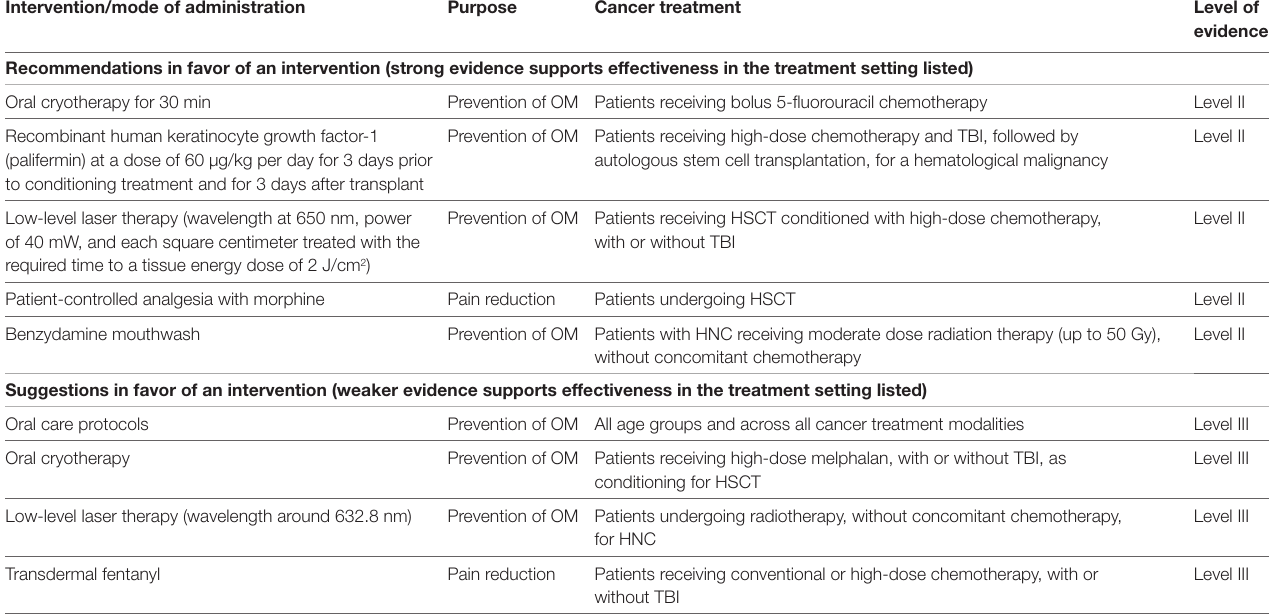
TAbLe 9 | Multinational Association for Supportive Care in Cancer/international Society for Oral Oncology (MASCC/iSOO) Clinical Practice Guidelines for oral mucositis (3). intervention/mode of